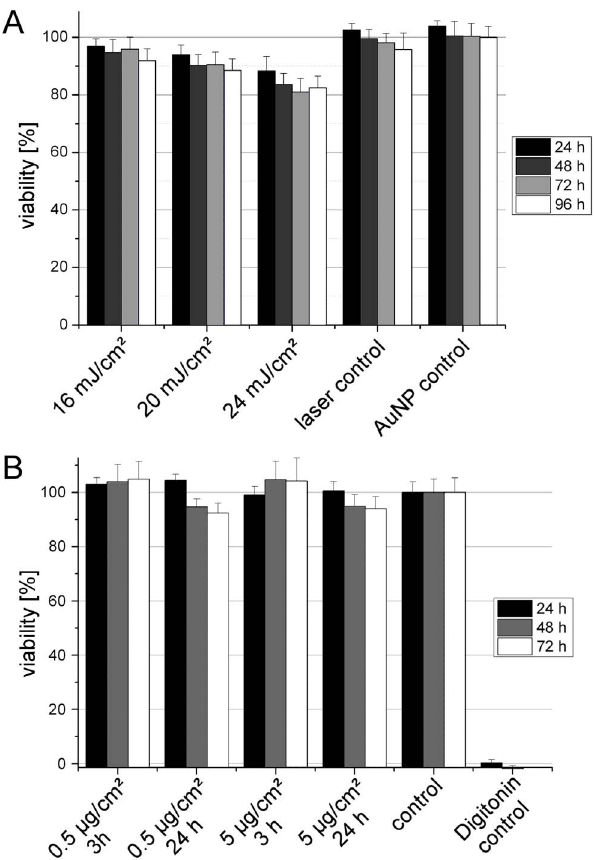
Figure 5. Course of the viability after GNOME laser transfection and AuNP incubation. A: The cells have been incubated with 0.5 m g/ cm 2 200 nm AuNP and were irradiated with different values of radiant exposure. At the indicated time points after laser treatment the cell viability was measured. For all conditions tested the viability stayed above 80%. B: ZMTH3 cells were incubated with 200 nm AuNP for 3 and 24 h respectively. No significant impact on the viability could be observed after 3 h of incubation. Values represent the mean of n $ 3 experiments + SEM.